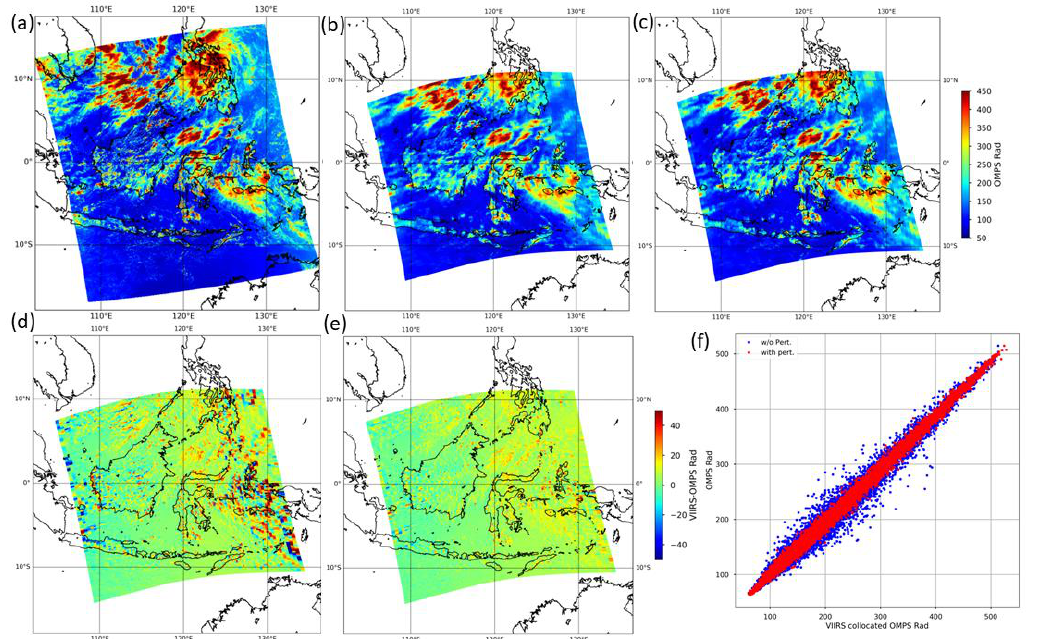
Figure 16. ( a ) VIIRS image at M01 band (412 nm) on 15 August 2021, ( b ) the correspondent medium resolution data on NOAA-20 image at 420 nm, ( c ) VIIRS-collocated image based on the OMPS-NM geometry characteristics, the radiance difference image between VIIRS-collocated and real OMPS-NM radiances, ( d ) based on the original OMPS geolocation fields and ( e ) with the ones with perturbation that perfectly are aligned with VIIRS, and ( f ) Scatter plot between real and VIIRS-collocated OMPS-NM radiances. In ( f ), the blue dots indicate the VIIRS-collocated OMPS-NM radiances using the original geolocation fields, while the red dots indicate those with perturbation. The radiance unit is W/(cm 3 Sr).